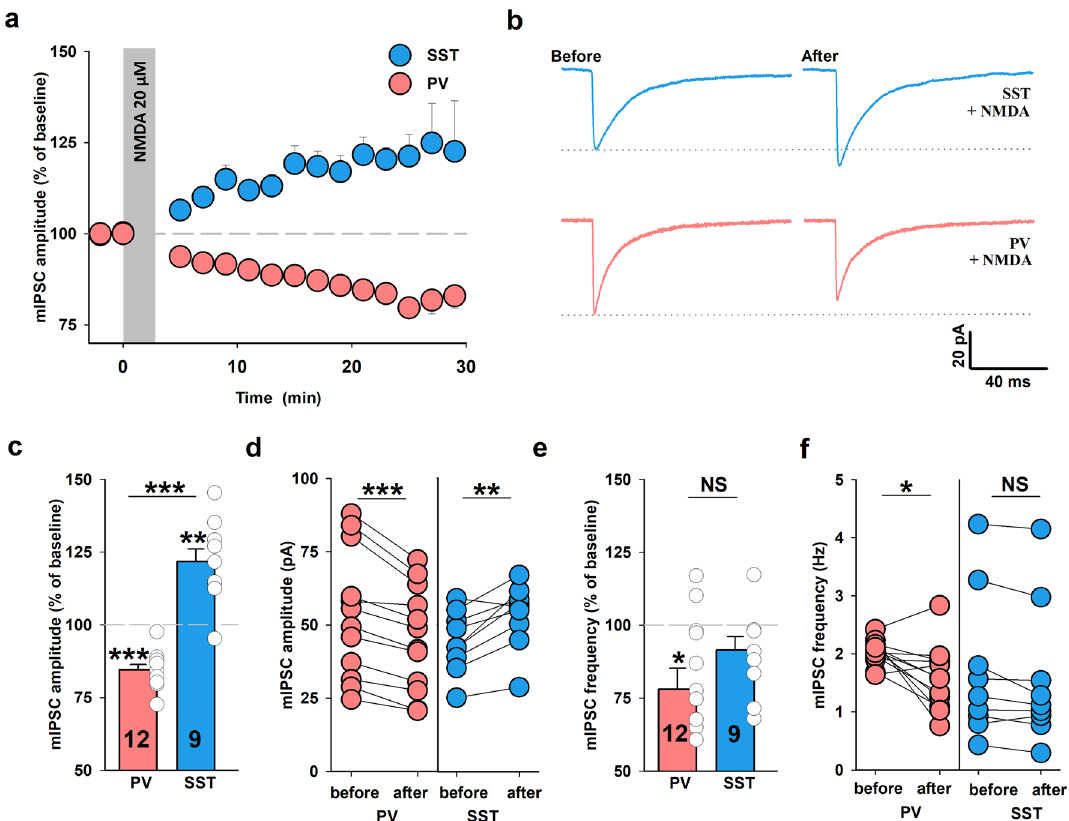
Figure 4. Brief NMDA treatment induces opposite sign plasticity in SST + and PV + INs. ( a ) Time courses of mIPSC amplitude after a brief NMDA exposure (3 min., 20 μM) in SST + (blue) and PV + INs (coral). The administration of NMDA is marked as the gray bar. Note that NMDA application significantly increased mIPSC amplitude in SST + INs (iLTP) and decreased mIPSC amplitude in PV + INs (iLTD). ( b ) Representative averaged mIPSC traces before and 16–18 min. after the end of NMDA treatment in SST + and PV + INs. Dotted line shows the mean value of mIPSC baseline amplitude. ( c ) Statistics for iLTD and iLTP magnitude 16–18 min. after the end of NMDA application (relative to baseline) in PV + and SST + INs. Asterisks above bins indicate significant change in amplitude relative to baseline. Additional test: Mann–Whitney Rank Sum Test, p < 0.001. ( d ) Average mIPSC amplitude measured from a single cell before and after NMDA stimulation in PV + INs and SST + INs. SST: paired t -test; PV: paired t -test with Wilcoxon Signed Rank Test. ( e ) The impact of NMDA administration on mIPSC frequency 16–18 min. after the end of plasticity induction in PV + and SST + INs (relative to baseline). Asterisk shows decrease in mIPSC frequency after iLTD induction. Additional test: t -test, p = 0.205. ( f ) Mean value of mIPSC frequency recorded from an individual PV + and SST + INs (paired t -test). Significant difference is marked * p < 0.05, ** p < 0.01, *** p < 0.001; NS,